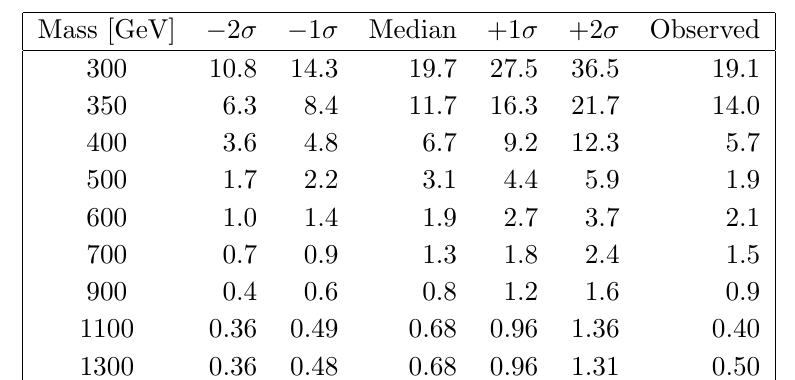
table 1 for di(cid:11)erent Higgs boson masses m A = H . The 95% CL limits of (tan (cid:12); m A ) are listed in tables 2 to 5 for di(cid:11)erent MSSM benchmark scenarios.